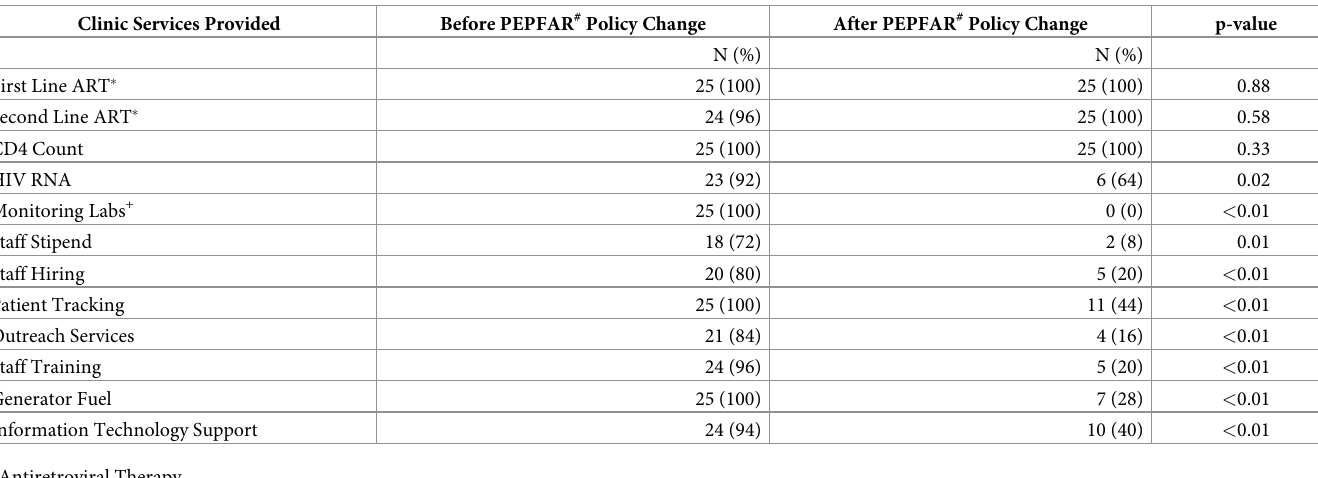
Table 2. Proportion of APIN clinics providing HIV clinical services before and after PEPFAR’s policy change. Clinic Services